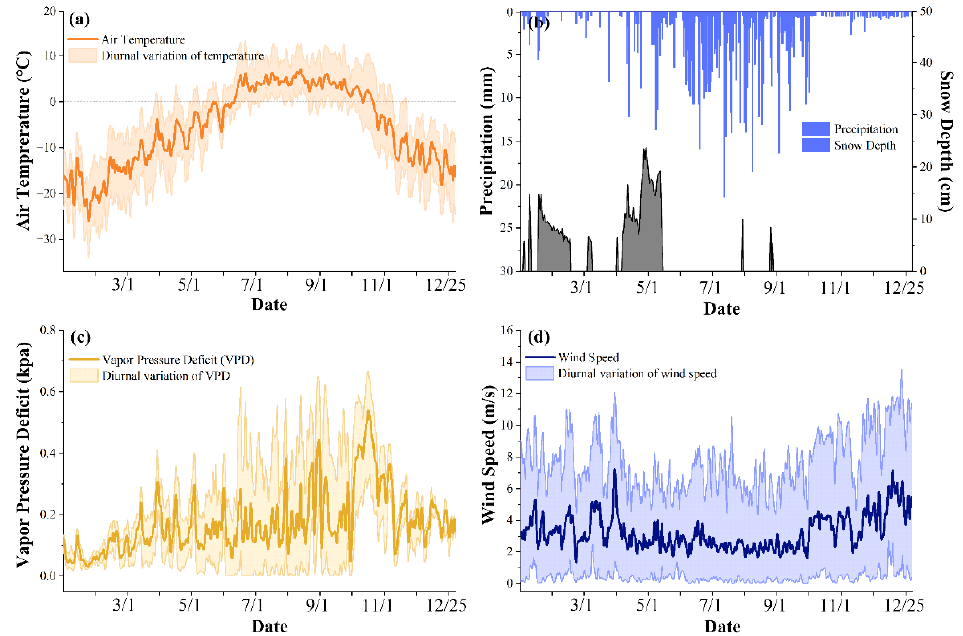
Figure 2. Variations in the ( a ) air temperature (AT) at a height of 2 m; ( b ) precipitation (bar) and snow depth (shaded graph); ( c ) vapor pressure deficit (VPD) at 2 m; and ( d ) wind speed (WS) at 2.5 m. All data are 30-min averages and ( a ) air temperature, ( b ) wind speed, and ( c ) VPD are shown with their respective daily maximums and minimums. The light color divides the growing season and non-growing periods.